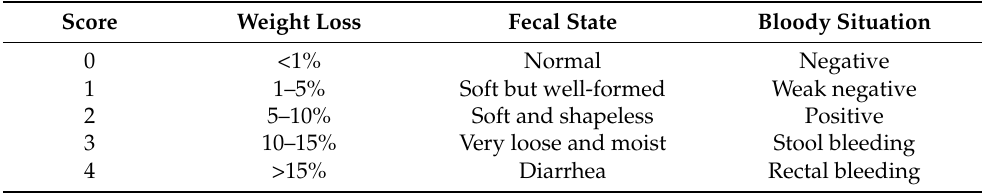
Table 1. The criteria for disease activity index (DAI) score.